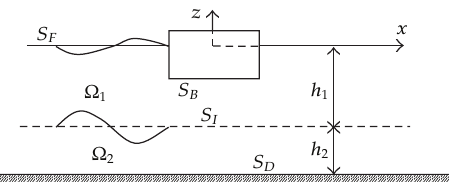
Figure 1: The coordinate